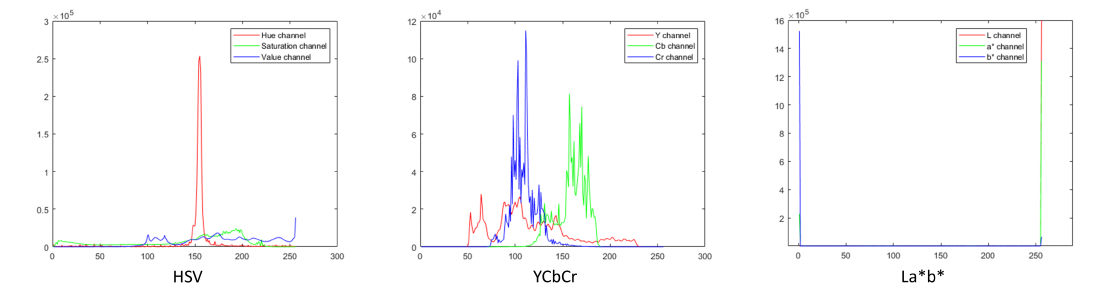
Figure 14. HSV, YCbCr, and CIEL*a*b* colour